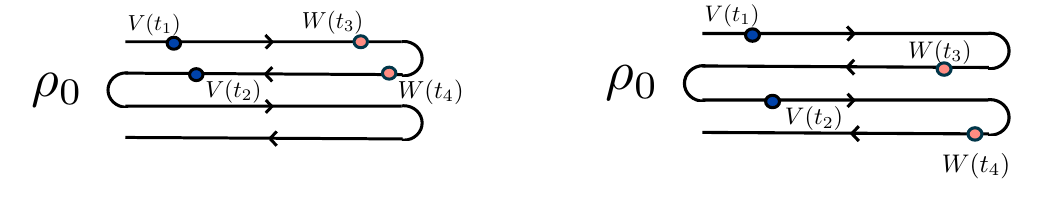
Figure 9 . Left: operator insertions for (6.9). Right: operator inserations for (6.10).